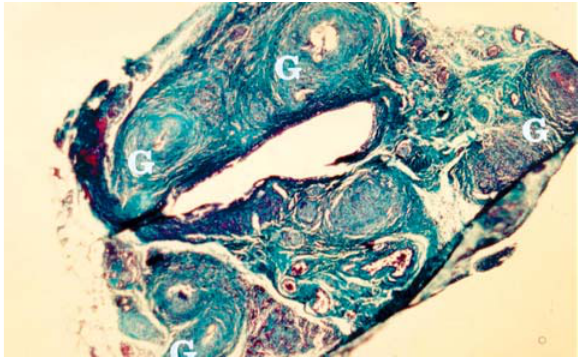
Figure 1 – Anastomotic cut edge in vasovasostomy with fibrin glue. Presence of some peripheral granulomas (G), foreign body (anchor point) and intense inflammatory reaction (Gomori trichrome,